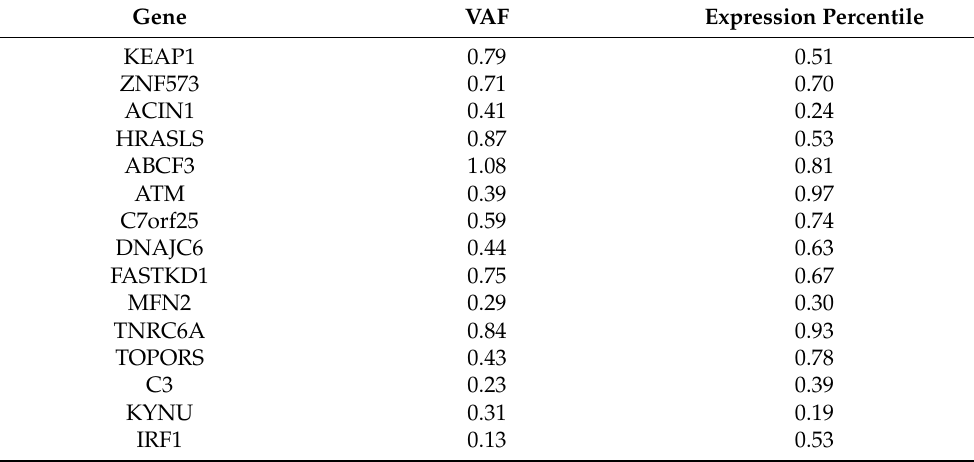
Table 2. Purity corrected VAFs and expression percentiles for genes leading to a NOP in lung tumor sample